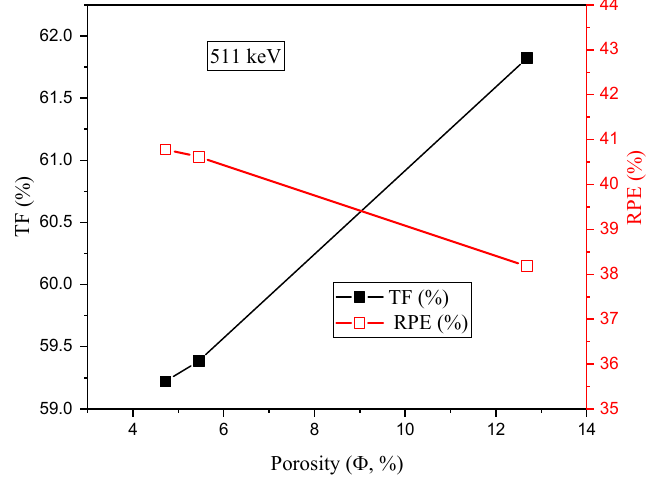
Figure 11. Dependence of both the transmission factor (TF, %) and radiation ‐ protection efficiency (RPE, %) on the fabricated ceramic samples’ porosity ( Φ , %). (RPE, %) on the fabricated ceramic samples’ porosity ( Φ ,